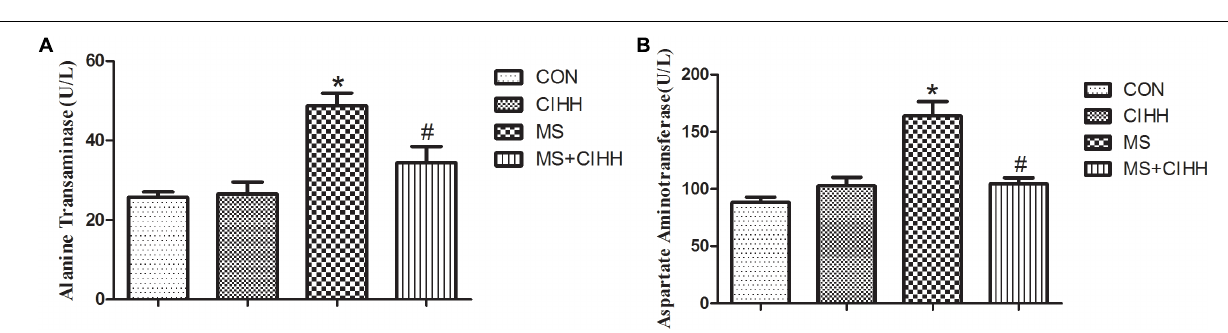
Compared with CON rats, the level of p-AMPK α (Thr172) was significantly down-regulated in MS rats ( P < 0.05, Figure 7 and Supplementary Figure S3 ). Compared with MS rats,